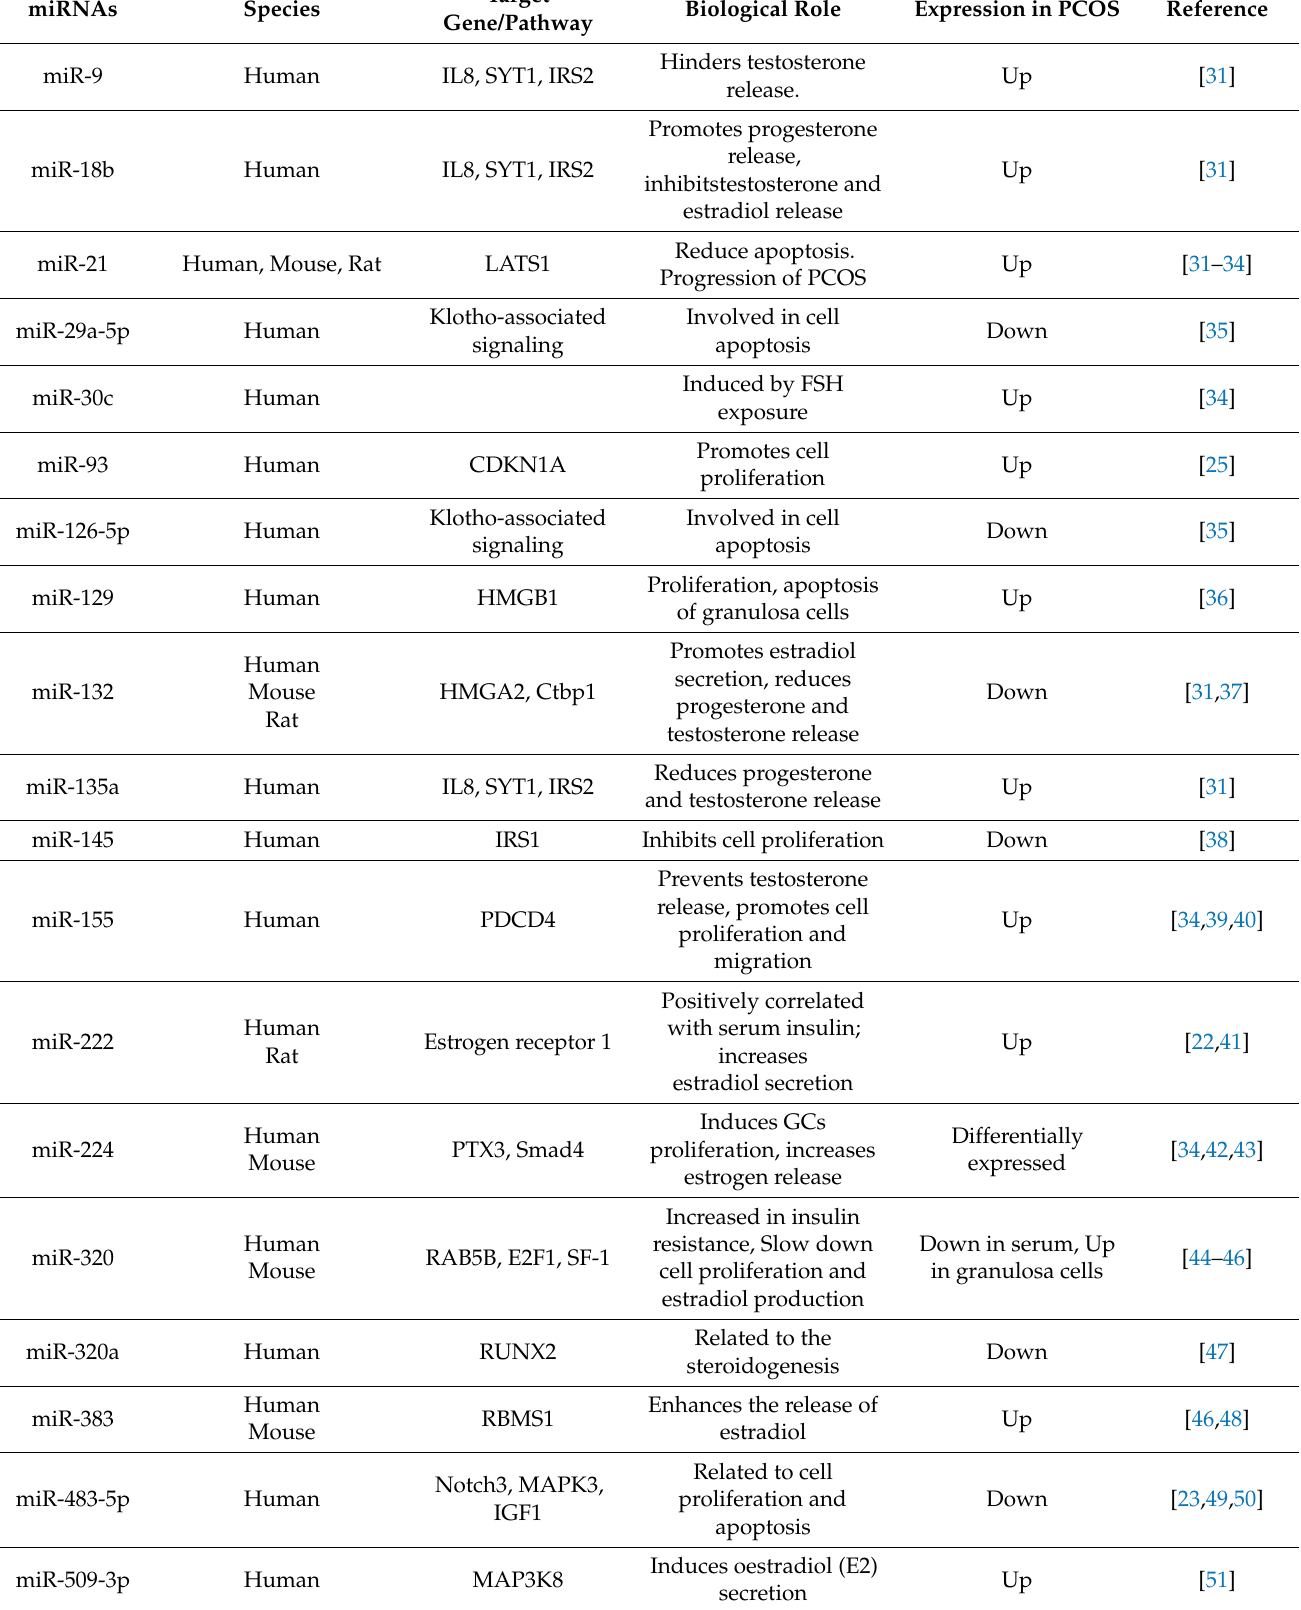
Table 1. Expression and regulation of miRNAs in the granulosa cells with known target genes in relation to PCOS.